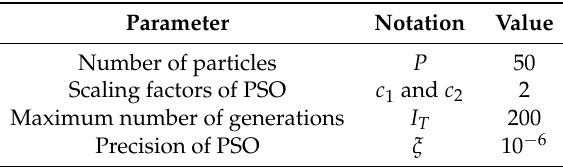
Table 3. Simulation parameters.